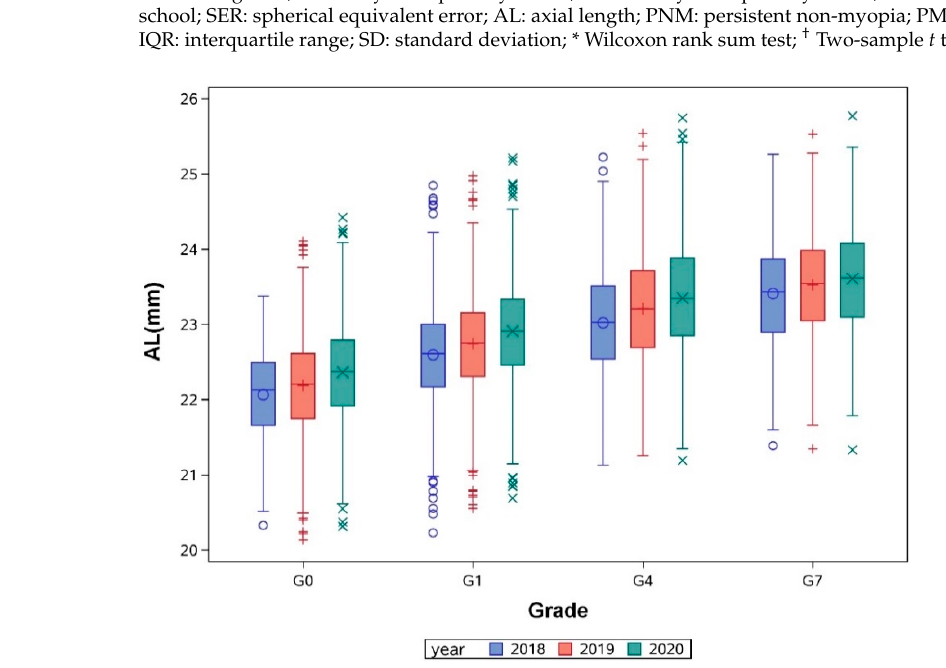
Figure 1. Annual axial length (AL) change from 3 to 15 years old in children from different grades with two-year follow-up. Table 1. Baseline distribution of SER and AL among persistent non-myopia and persistent myopia groups.